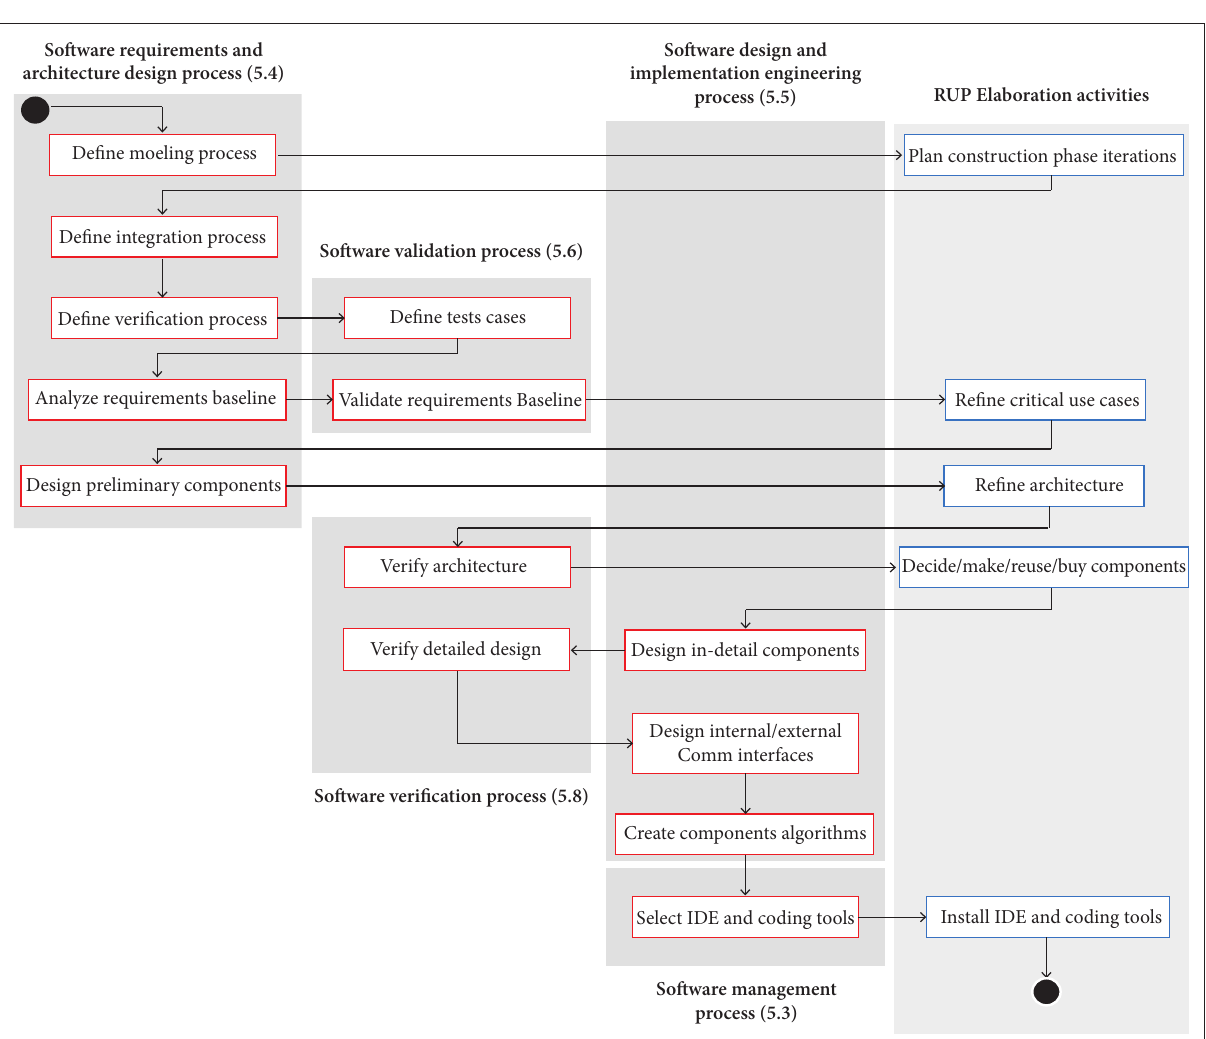
figure 8. Elaboration phase activities for the